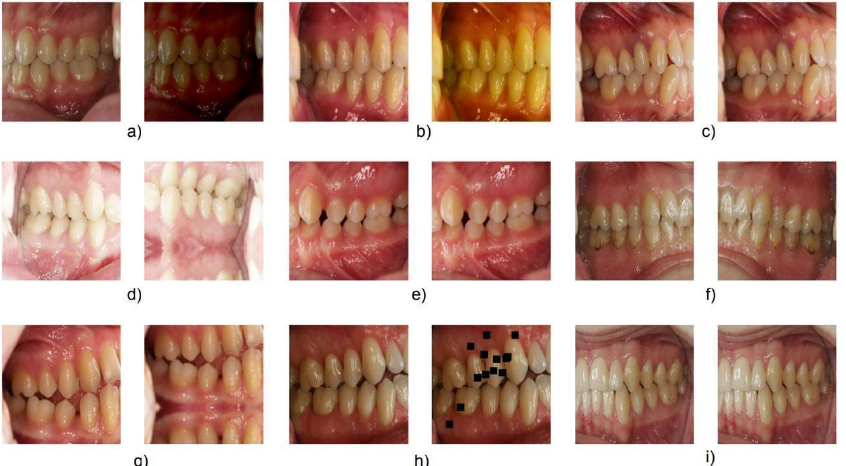
Figure 3. Original images together with their augmented version. We observed color changes in ( a , b ), no transformation in ( c ), horizontal and vertical flipping together with vertical shift in ( d ), blurring in ( e , i ), horizontal flipping in ( f ), vertical shift in ( g ), and dropout in ( h ).